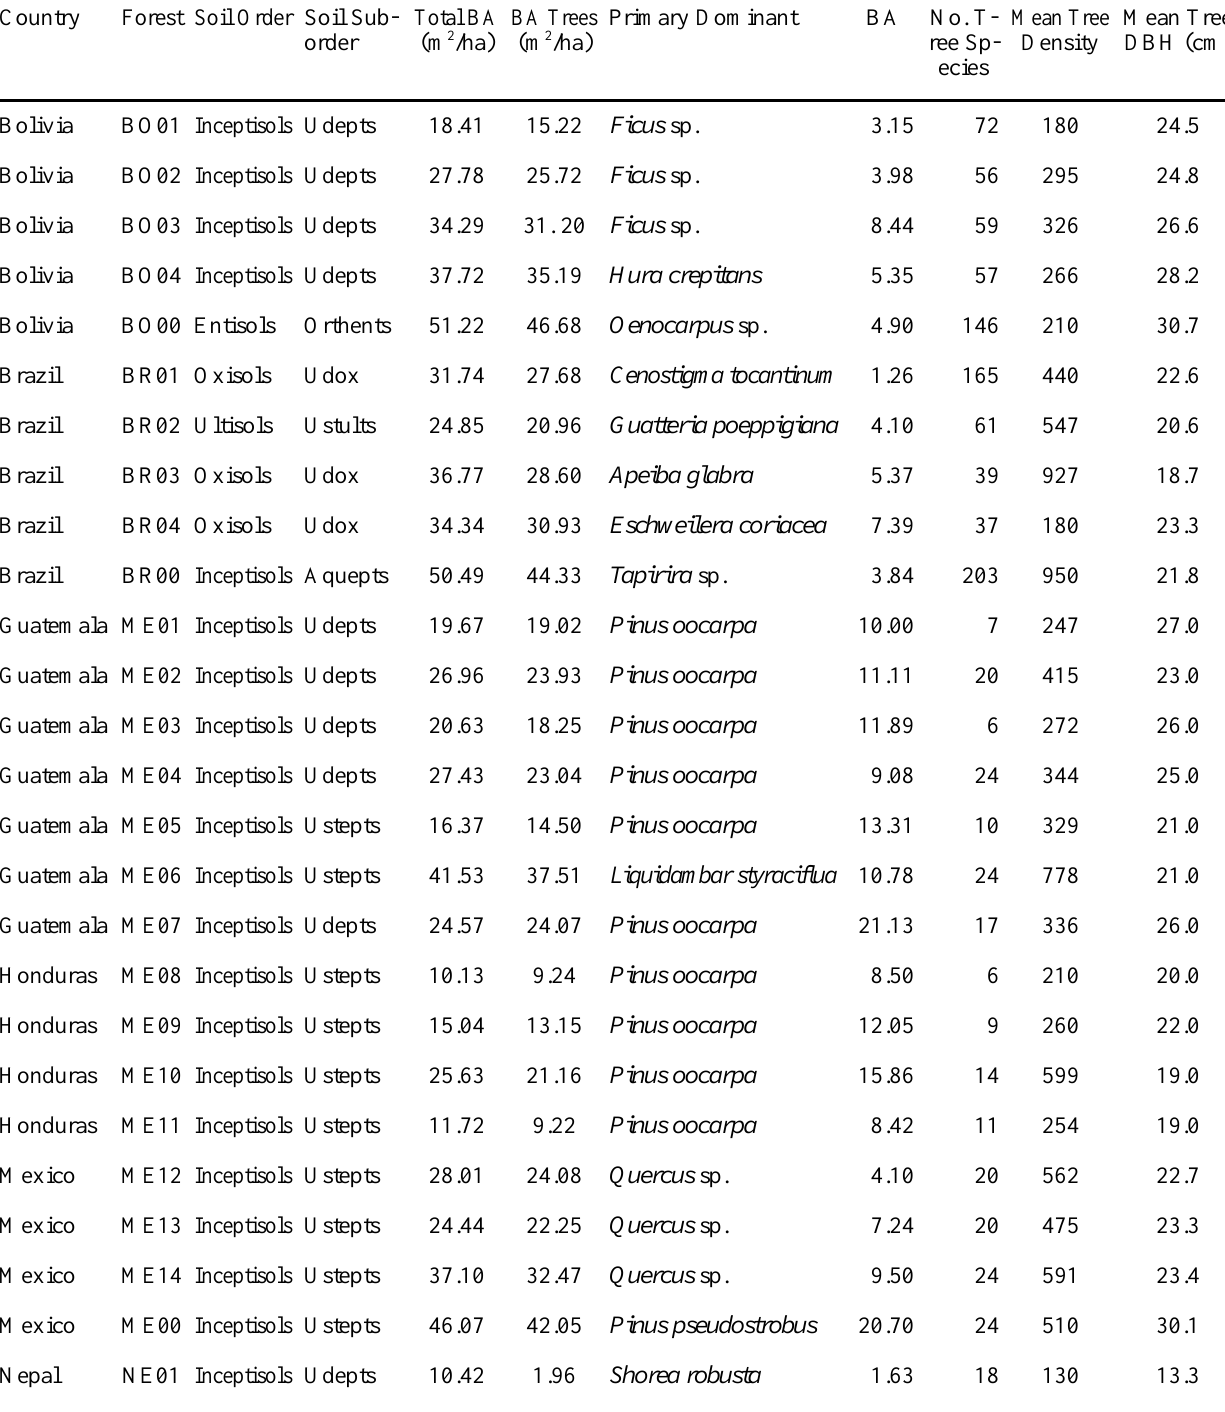
Table 1. Summary of characteristics of the study and reference forests (00) in each region.